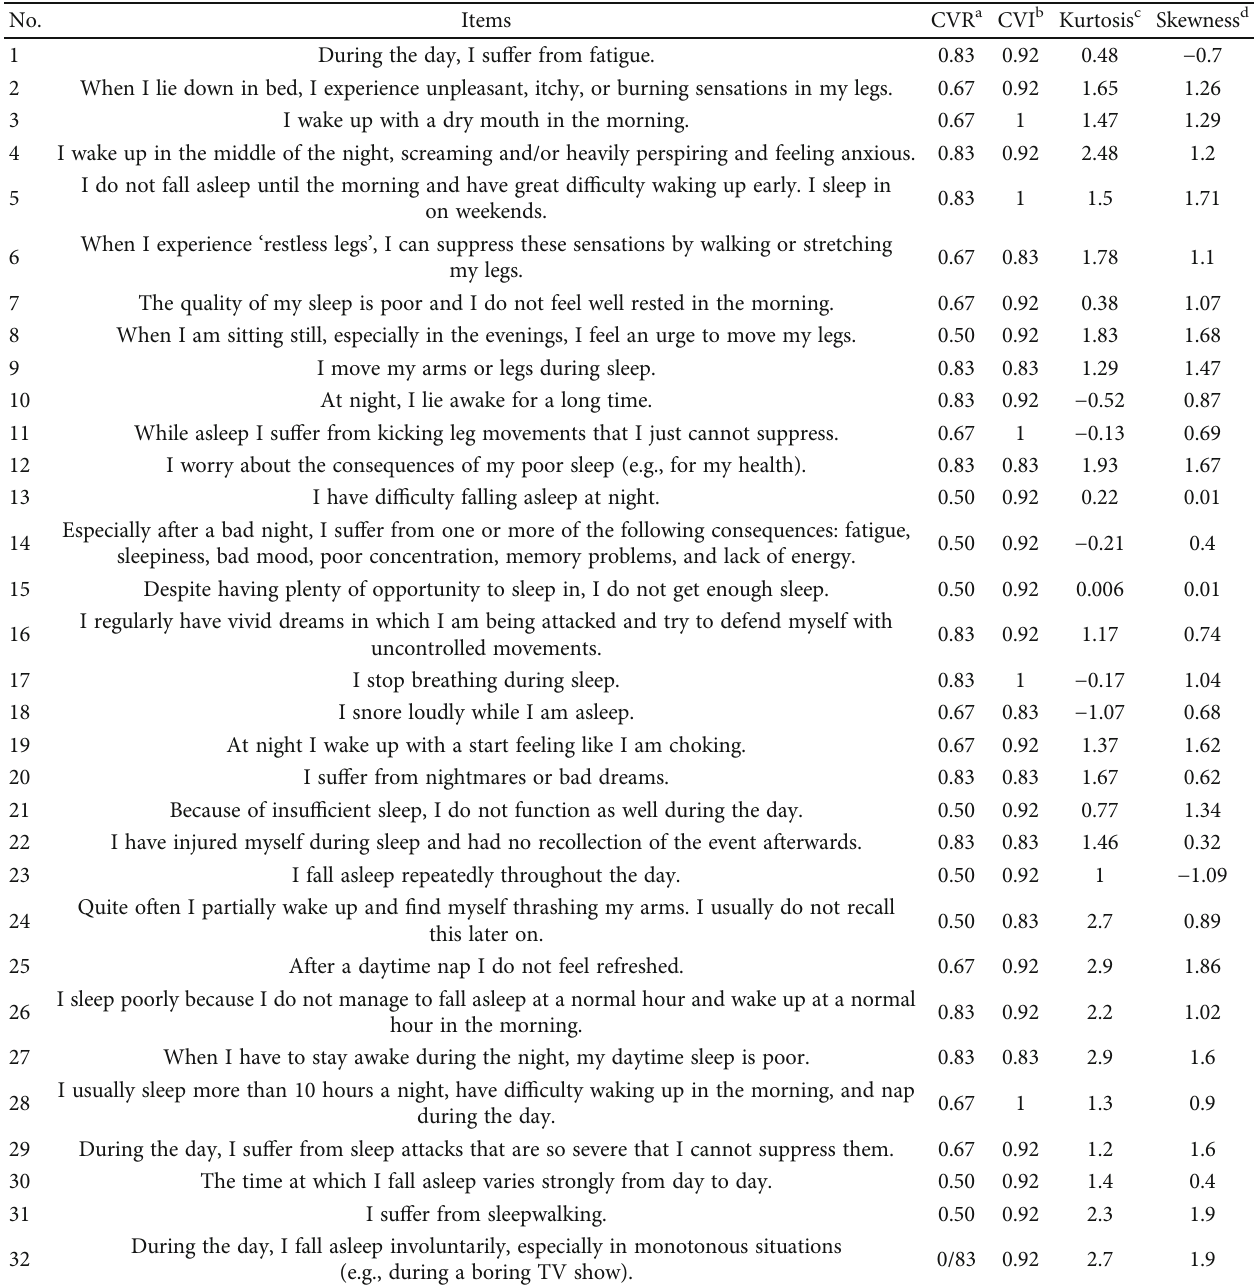
Table 2: The ratio and index of content validity and multivariate normality index of the tool items. No. Items During the day, I su ff er from fatigue.